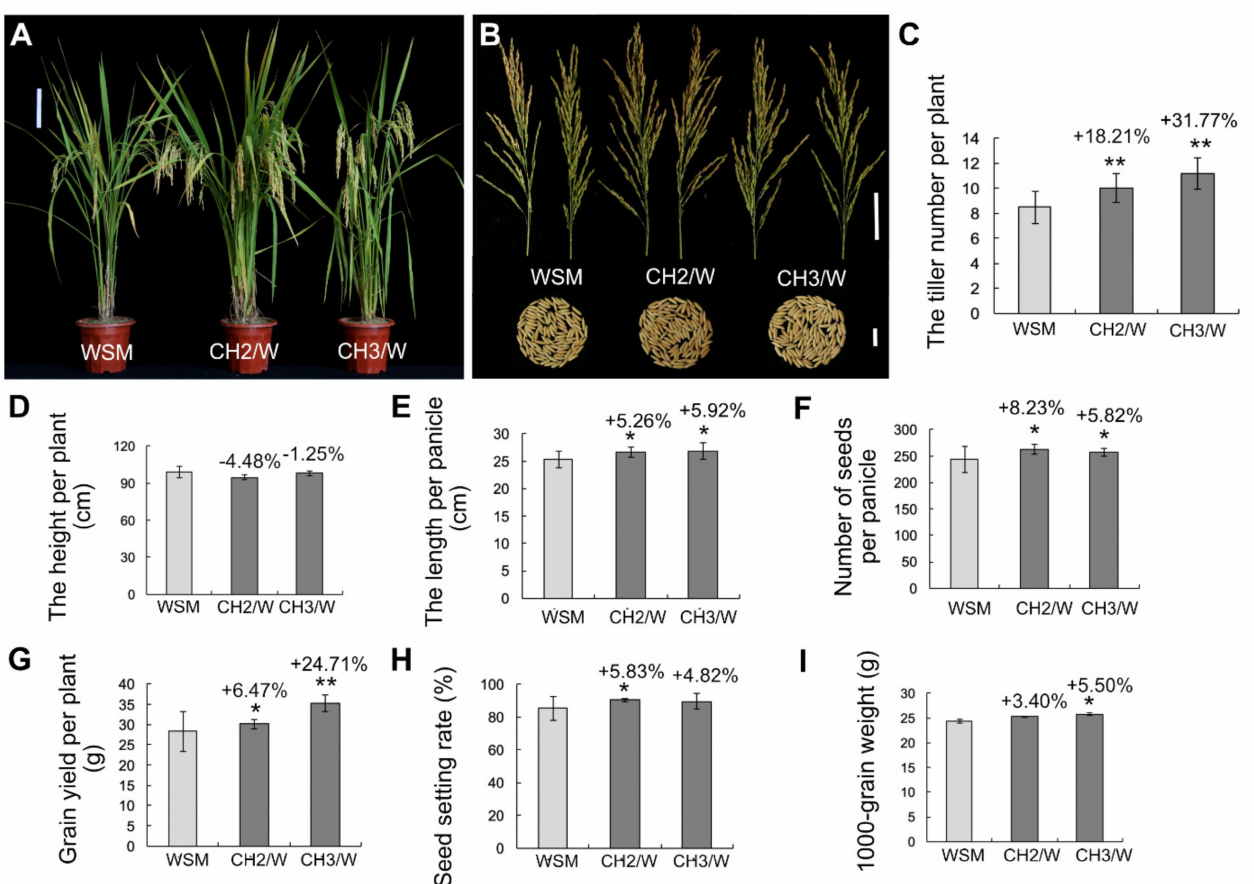
Figure 3. Yield traits of WSM and OsHXK1-Cas9 plants seeded in the fall seedings. ( A ) Images of WSM, CH2/W, and CH3/W plants at the flowering stage. Bar = 20 cm. ( B ) Comparisons of panicles and 100 grains of WSM, CH2/W, and CH3/W plants. Bar = 5 cm (top), 2 cm (bottom). ( C ) Tiller number of WSM, CH2/W, and CH3/W plants. ( D ) Height of WSM, CH2/W, and CH3/W plants. ( E ) Length per panicle of WSM, CH2/W, and CH3/W plants. ( F ) Number of grains per panicle of WSM, CH2/W, and CH3/W plants. ( G ) Single-plant yield of WSM, CH2/W, and CH3/W plants. ( H ) Seed setting rate of WSM, CH2/W, and CH3/W plants. ( I ) 1000-grain weight of WSM, CH2/W, and CH3/W plants. The data are the means ± SDs; *, 0.01 ≤ p < 0.05; **, 0.001 ≤ p < 0.01 according to Student’s t